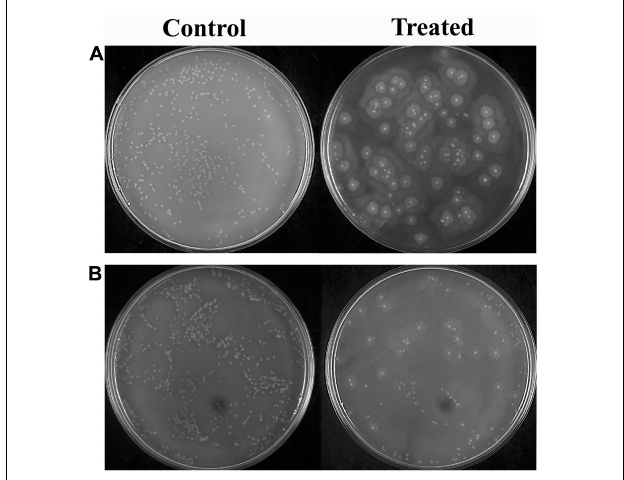
FIGURE 5 | Effect of HMB on blood survivability of Proteus mirabilis (A) ATCC and (B) CI. Representative images clearly depict the efficient inhibition of blood survival rate of HMB (at its MBIC) treated sample when compared with control. HMB, 2-hydroxy-4-methoxybenzaldehyde; ATCC, American Type Culture Collection; CI, clinical isolate; MBIC, minimum biofilm inhibitory concentration.